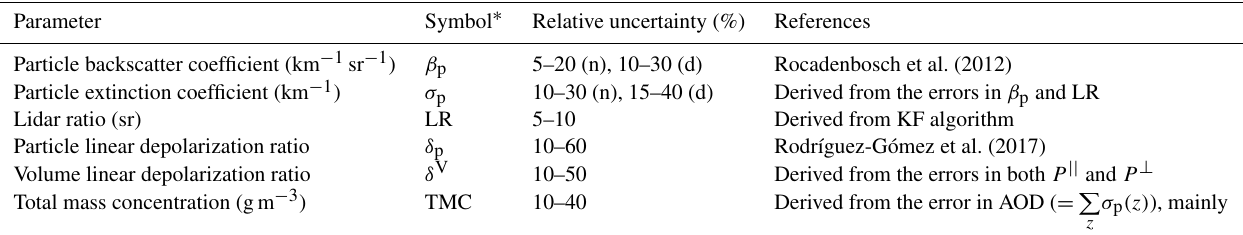
Table 1. Relative uncertainties for the P-MPL-derived particle optical properties (at 532nm wavelength) and mass concentrations. (n) and (d) stand for night-time and daytime P-MPL